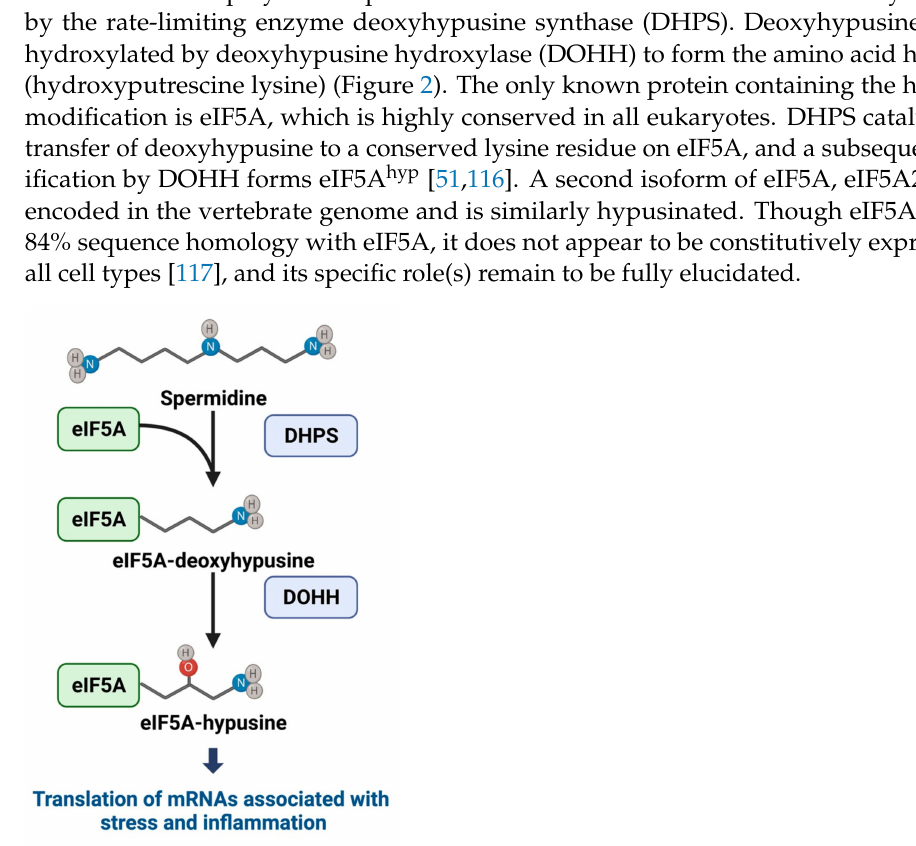
Figure 2. Hypusine Pathway . Spermidine is used as a substrate to form deoxyhypusine by the rate-limiting enzyme deoxyhypusine synthase (DHPS), which then transfers deoxyhypusine to eIF5A. Deoxyhypusine is then converted to hypusine by deoxyhypusine hydroxylase (DOHH), resulting in hypusinated